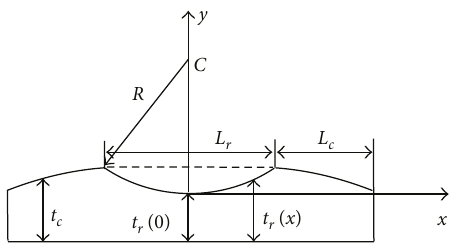
Figure 5: Schematic diagram of the corneal